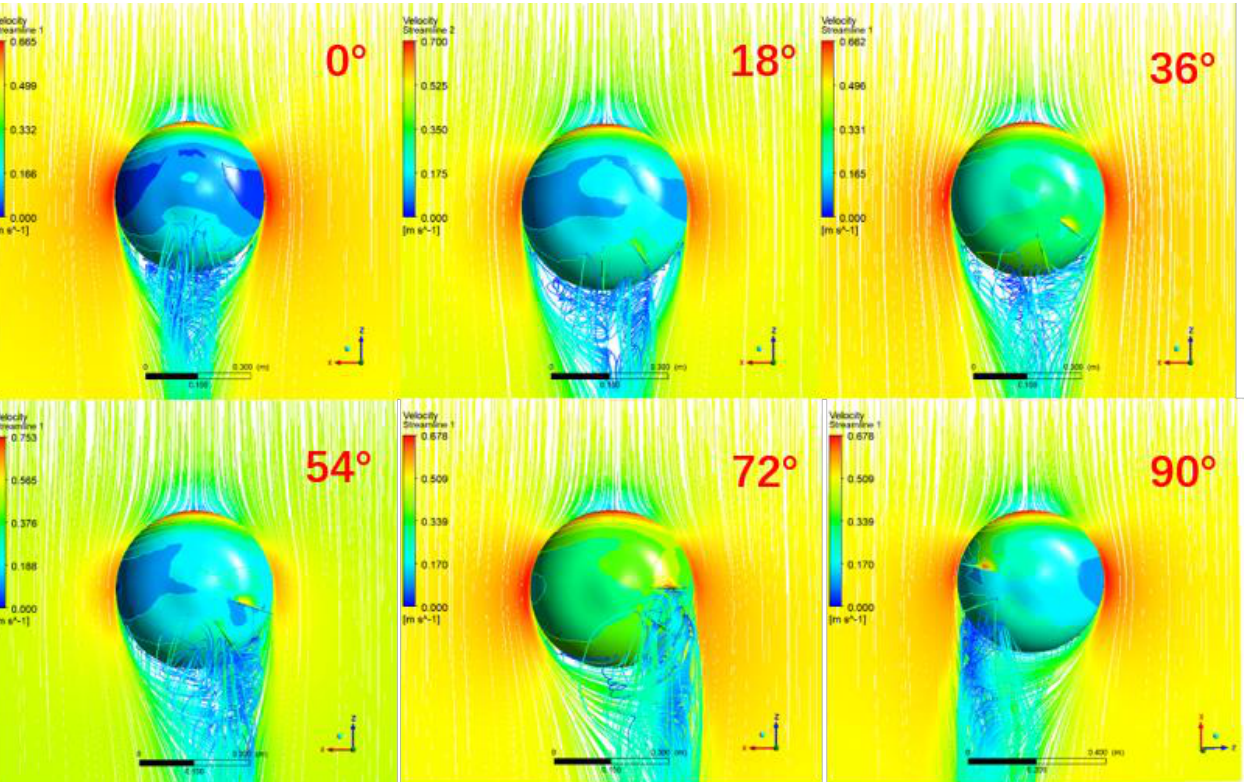
Figure 5. Velocity streamlines of the shell with fins at different angles. As the angle is rotated, the velocity around the fins increases and reaches a maximum at 72 degrees.